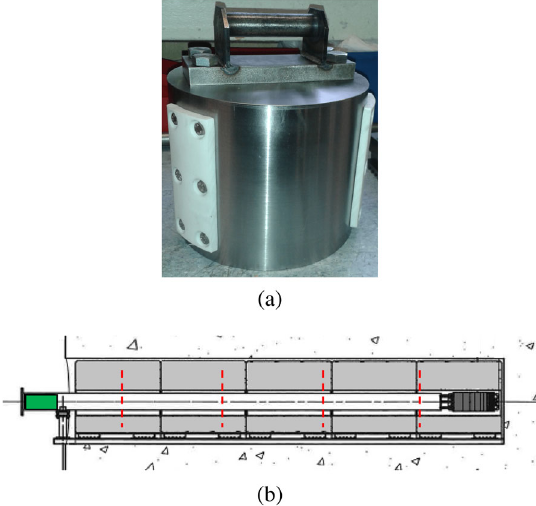
FIG. 16. (a) Stainless steel radiation shielding plug. (b) In green, insertion of the radiation plug at the end of the beam pipe of the original dump core-shielding assembly. The dashed lines indicate the position of the cuts performed by the remotely operated saw on the beam pipe.